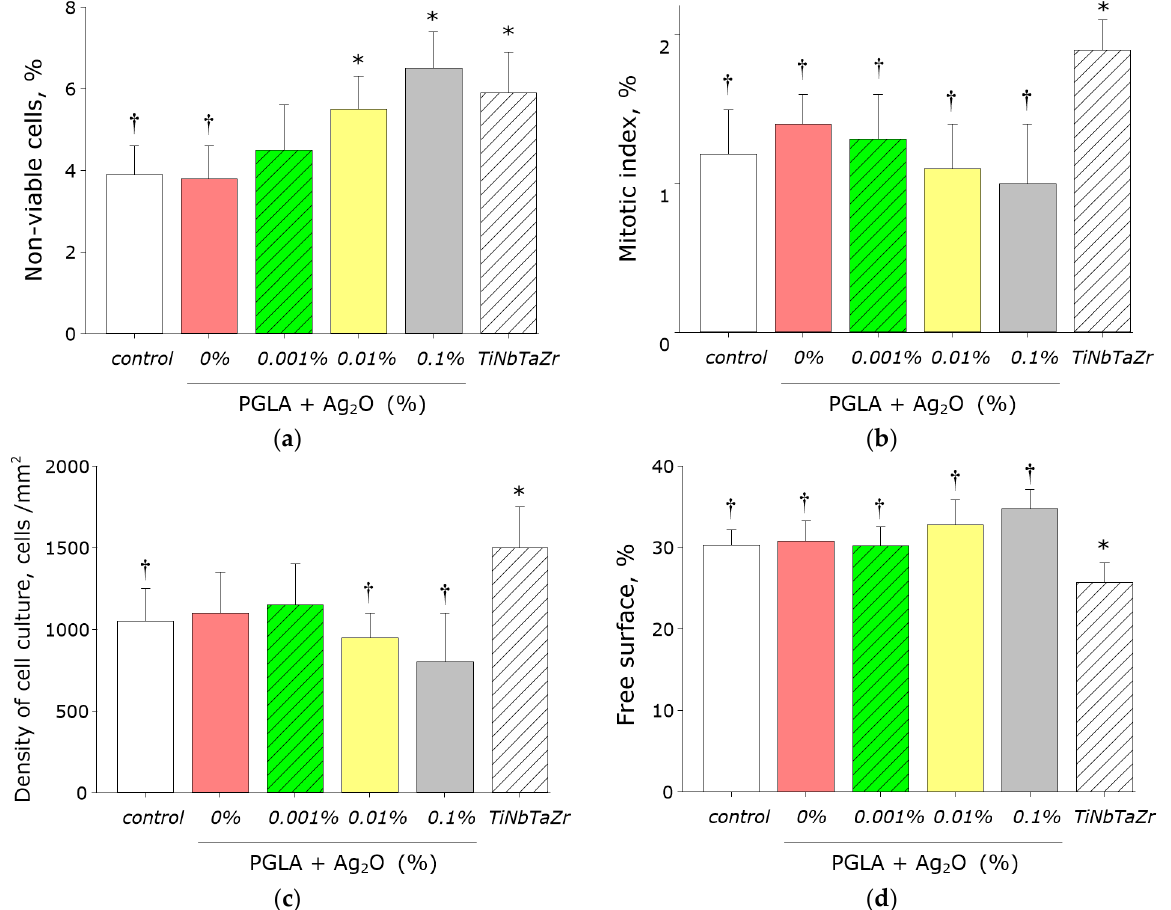
Figure 11. Effect of composite PLGA/Ag 2 O NPs on the main characteristics of growth and development of cell culture: ( a ) Influence of composite material on the viability of SH-SY5Y cell culture; ( b ) Influence of composite material on the SH-SY5Y cells mitotic index; ( c ) Influence of composite material on the cells SH-SY5Y density; ( d ) Influence of composite material on the colonisation rate of free surface by cells. *— p < 0.05 versus control. † — p < 0.05 versus NiNbTaZr group. Data are presented as mean ± SE.